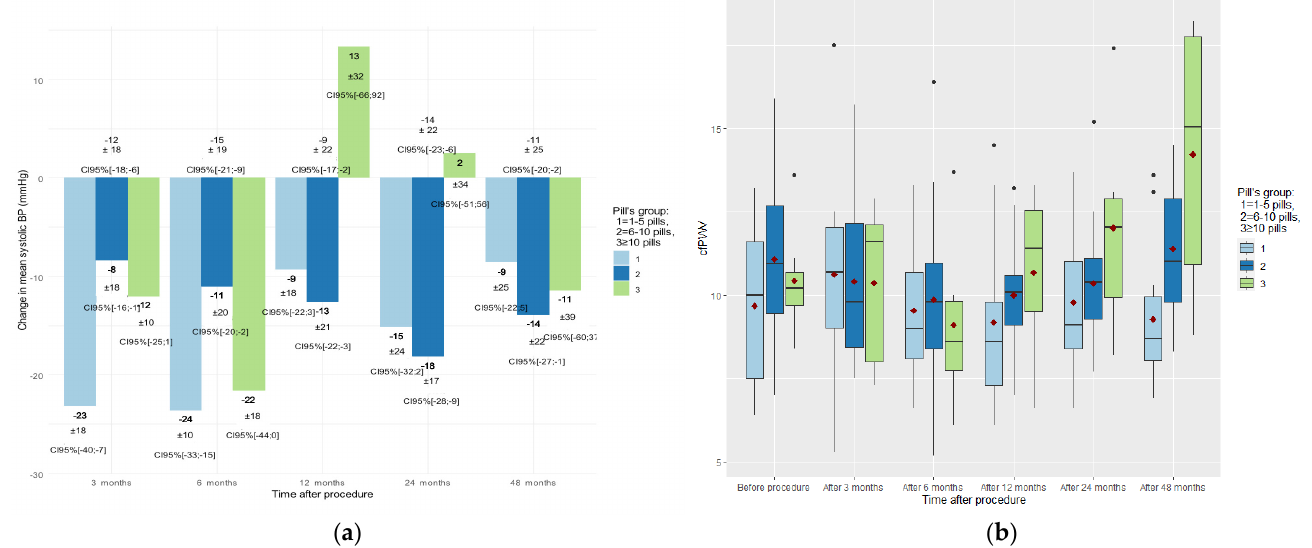
Figure 5. Influence of the total number of pills on ( a ) 24 h mean systolic blood pressure mean reduction (in mmHg) and ( b ) arterial stiffness, CfPWV (in m/s) over observation period.